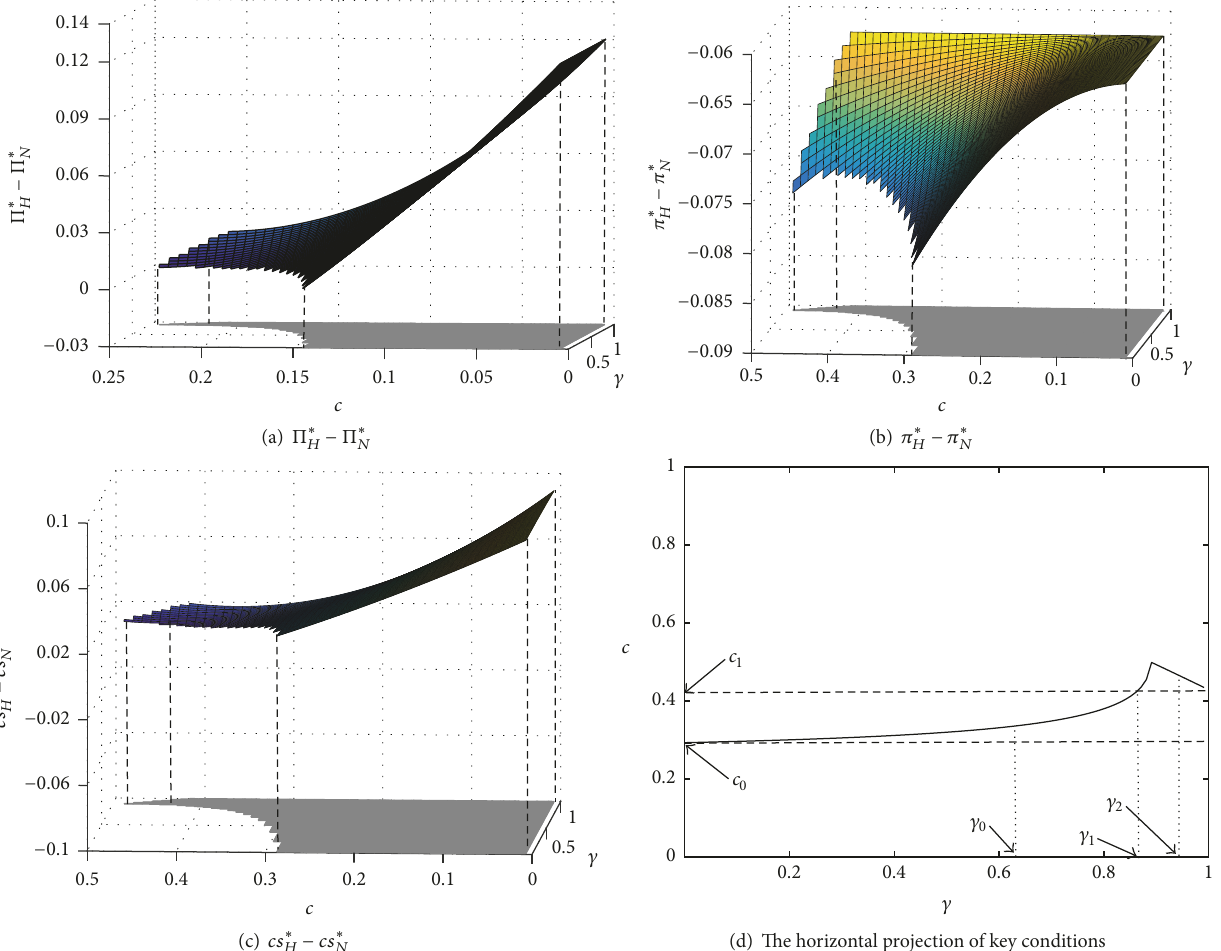
Figure 2: Key conditions of Model 𝐻